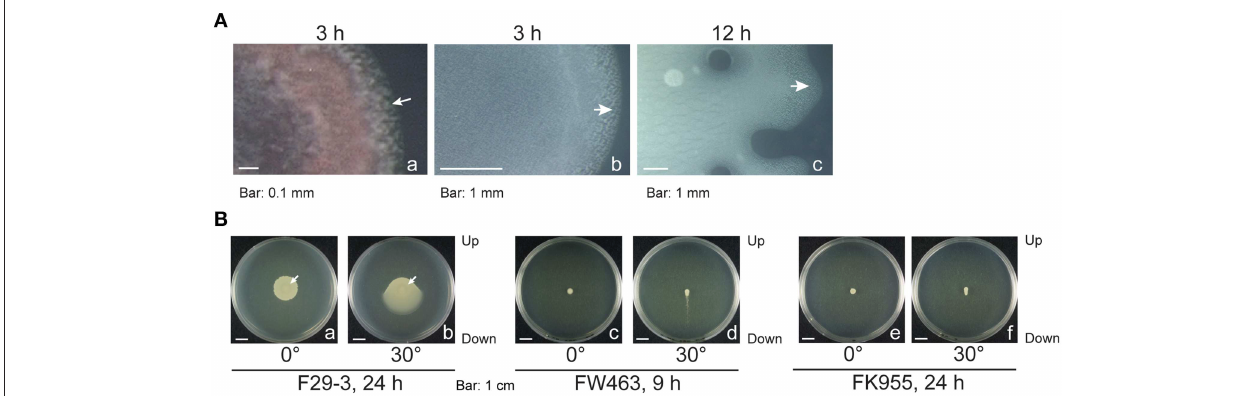
FIGURE 3 | Presence of water in B. subtilis F29-3 colonies. (A) An LB-0.4 plate was inoculated with bacteria that were mixed with red fluorescence beads and cultured for 3h. Images of the bacterial colony and red fluorescence were merged to show the expansion of the colony from the inoculation site (a) . B. subtilis F29-3 colonies without the red fluorescence beads were cultured for 3h (b) and 12h (c) , and observed under a stereomicroscope. White arrows indicate motile bacterial packs. (B) B. subtilis F29-3 colonies were cultured for 24h on LB-0.4 agar plates that were laid flat (a) or tilted 30 ◦ (b) . B. subtilis FW463 and FK955 were cultured for